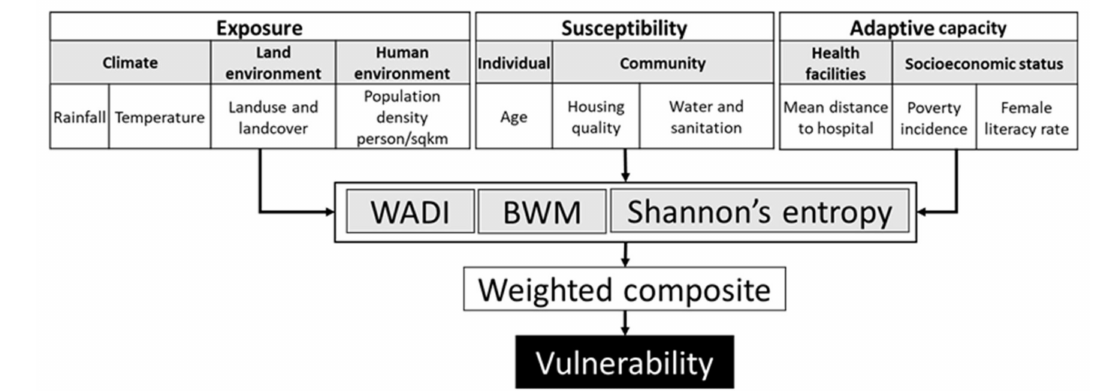
Figure 2. Conceptual framework for constructing the dengue vulnerability indices. Indicators of exposure, sensitivity, and adaptive capacity were combined using weights corresponding to the available evidence from the